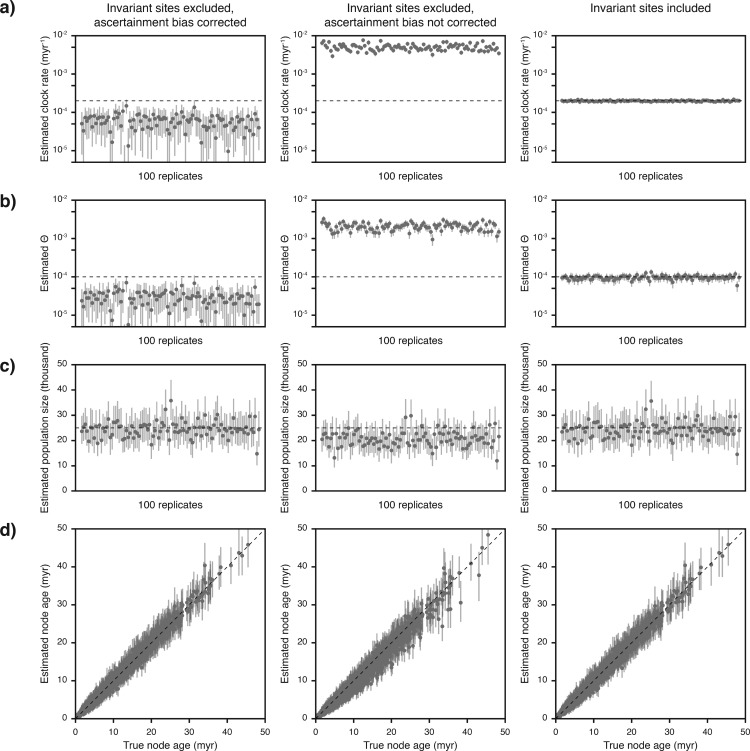
Estimates of node ages, the clock rate, \documentclass[12pt]{minimal}
\usepackage{amsmath}
\usepackage{wasysym}
\usepackage{amsfonts}
\usepackage{amssymb}
\usepackage{amsbsy}
\usepackage{upgreek}
\usepackage{mathrsfs}
\setlength{\oddsidemargin}{-69pt}
\begin{document}
}{}$\Theta$\end{document}, and the population size, with and without ascertainment bias (experiment 4). Results are based on data sets of 1 000 SNPs generated for each of 100 species trees, analyzed with and without SNAPP’s ascertainment-bias correction or after adding invariant sites to the data sets. Gray circles indicate mean estimates and 95% HPD intervals are marked with vertical bars. The visualization of node-age estimates in a) is equivalent to the illustration in Fig. 1, except that only unconstrained nodes are shown. Note that logarithmic scales are used for estimates of the clock rate (a) and \documentclass[12pt]{minimal}
\usepackage{amsmath}
\usepackage{wasysym}
\usepackage{amsfonts}
\usepackage{amssymb}
\usepackage{amsbsy}
\usepackage{upgreek}
\usepackage{mathrsfs}
\setlength{\oddsidemargin}{-69pt}
\begin{document}
}{}$\Theta$\end{document} (b).